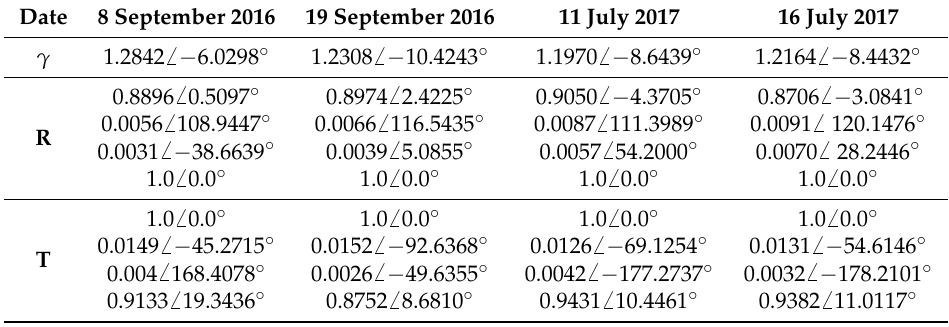
Table 2. The extracted polarimetric distortion parameters by the improved algorithm of this paper.